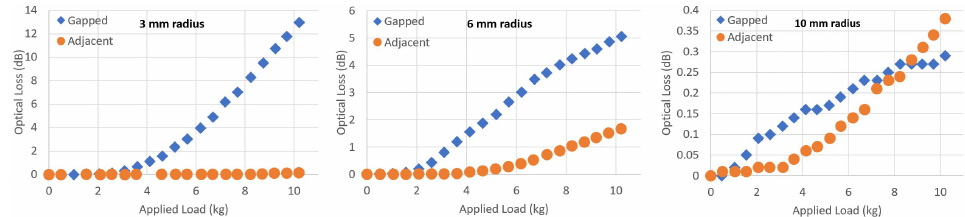
Figure 8. Experimental comparison of the optical loss when using impactors with gapped and adjacent protrusions. SSMF was used in all cases.